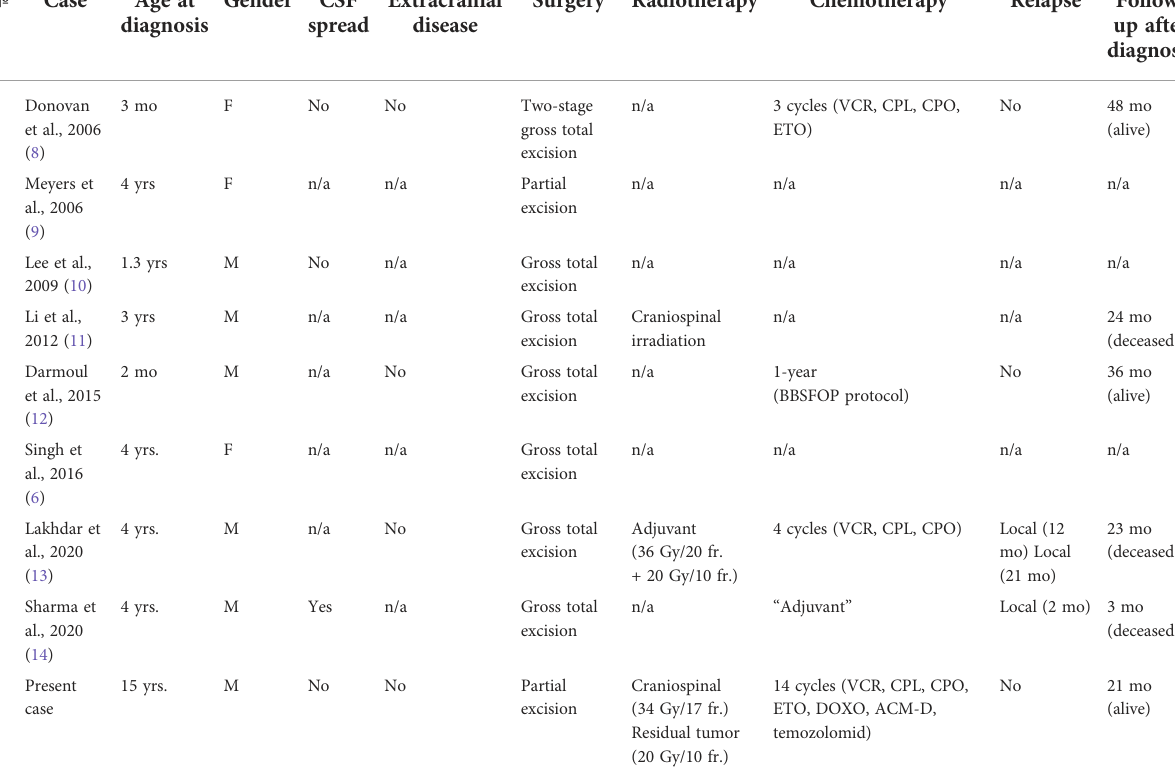
TABLE 2 Literature review of cases of pediatric lateral ventricle Atypical Teratoid/Rhabdoid Tumor (6, 8 – 14). №